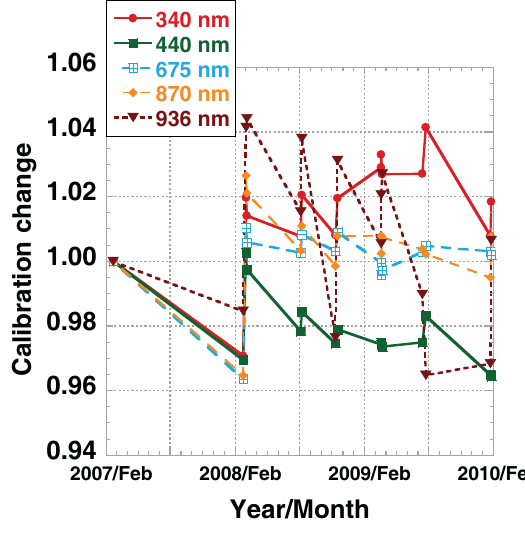
Fig. 1. Microtops (S/N 3657) calibration history.